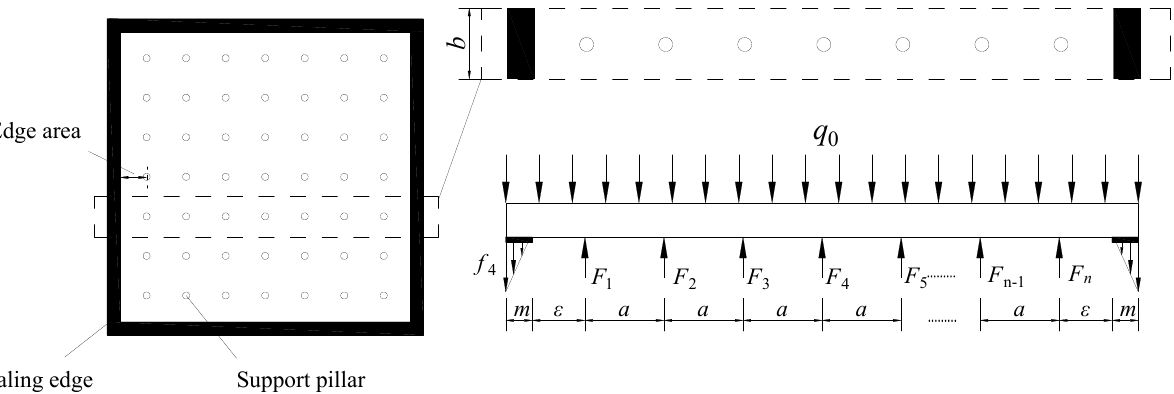
Figure 3. Schematic diagram of the force unit, the width of force unit is b , and supporting pillars are located at the midpoint in the width direction.